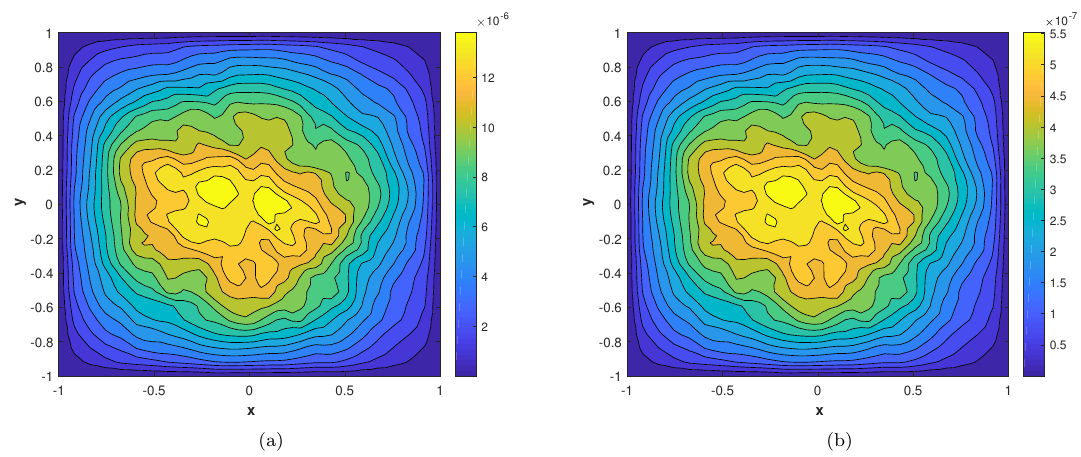
Figure 15: (a) Contour plot of Ab Error at time level T = 1 . (b) Contour plot Rms Error at time level T = 1 .